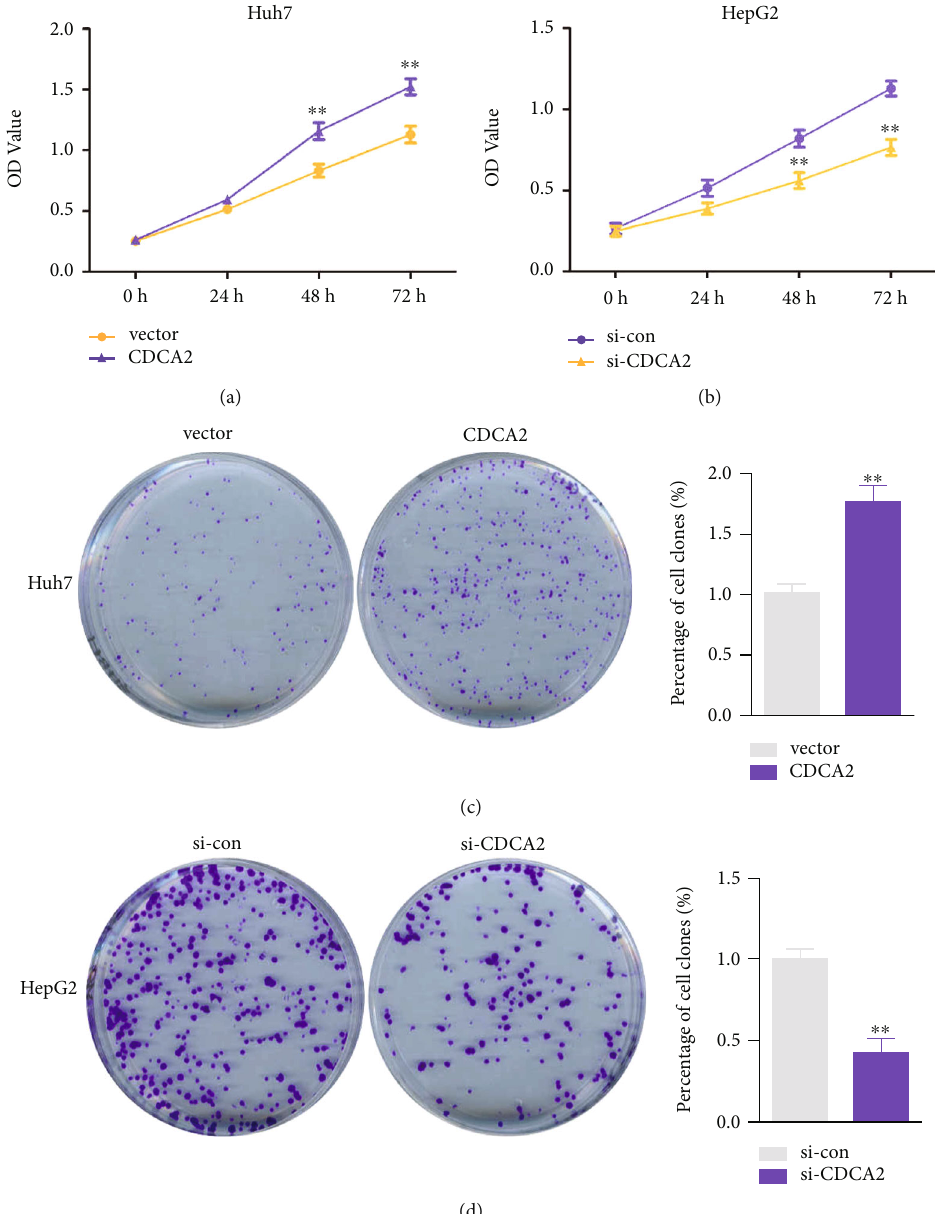
Figure 2: Estimation of hepatocellular carcinoma cells growth ability with cell division cycle associated 2 (CDCA2) abnormal expression. (a) values in Huh7 cells were signi fi cantly increased with CDCA2 upregulation. (b) Knockdown of CDCA2 decreased the OD The OD 450 values in HepG2 cells. (c) The colonies number in Huh7 cells was obviously elevated with CDCA2 overexpression. (d) CDCA2 deletion eliminated the increasing trend of HepG2 cells clone number. ** p < 0 : 01 versus vector or